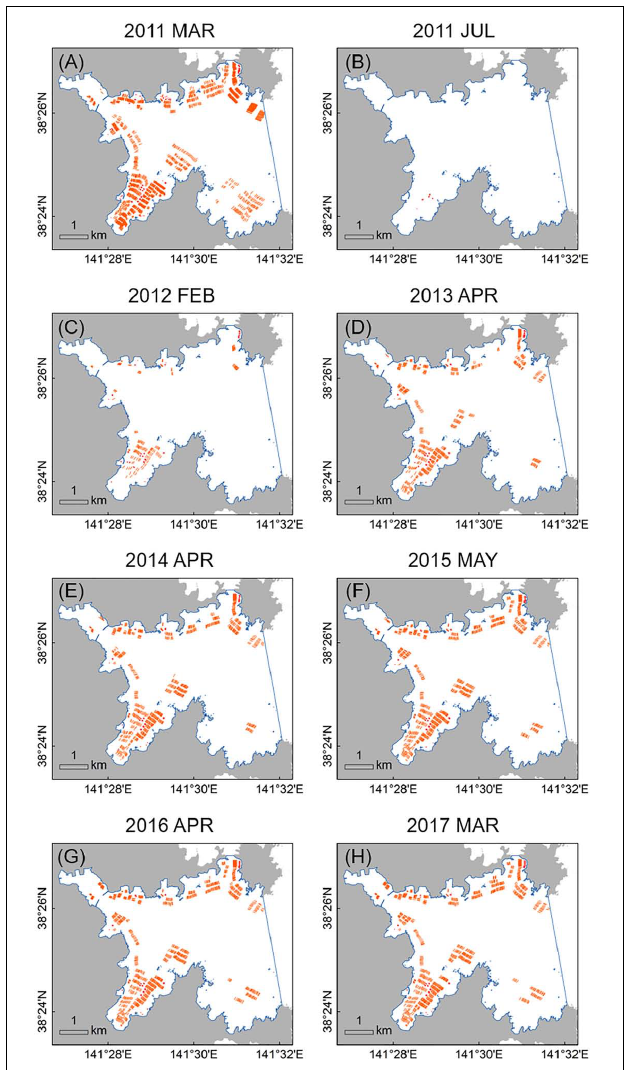
FIGURE 7 | Time series of distribution maps for aquaculture facilities in Onagawa Bay (orange polylines and red polygons represent long-lines and fish cages, respectively, and blue solid line defines the boundary of Onagawa Bay for this study): (A) March 2011 (just before the 2011 earthquake and tsunami); (B) July 2011; (C) February 2012; (D) April 2013; (E) April 2014; (F) May 2015; (G) April 2016; and (H) March 2017.